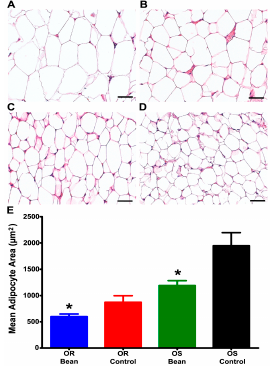
Figure 1. Adipocyte image analysis of H&E stained parametrial fat. ( A ) OS Control n = 7; ( B ) OS Bean n = 7; ( C ) OR Control n = 6; ( D ) OR Bean n = 6; ( E ) Graph of adipocyte image analysis results. Factorial ANOVA: strain p = 0.0001, diet p = 0.002, interaction p = 0.112; * different than respective control ( p < 0.05). Images are shown at 400 × magnification for clarity, but analysis was done at 100 × magnification, bars = 40 µ